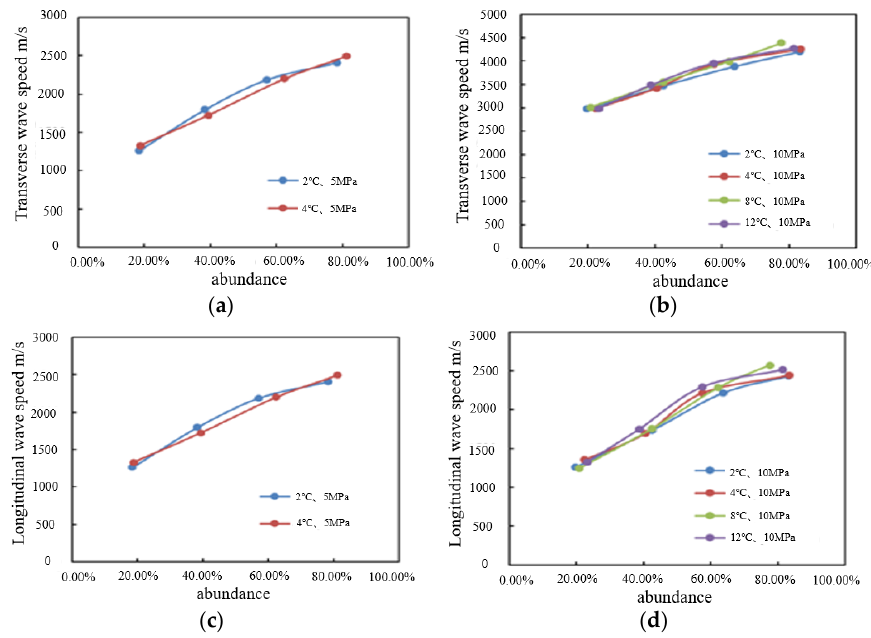
Figure 9. Variation of wave velocity with abundance ( a ) Transverse wave, pressure is 5 MPa; ( b ) Transverse wave, pressure is 10 MPa; ( c ) Longitudinal wave, pressure is 5 MPa; ( d ) Longitudinal wave, pressure is 5 MPa.